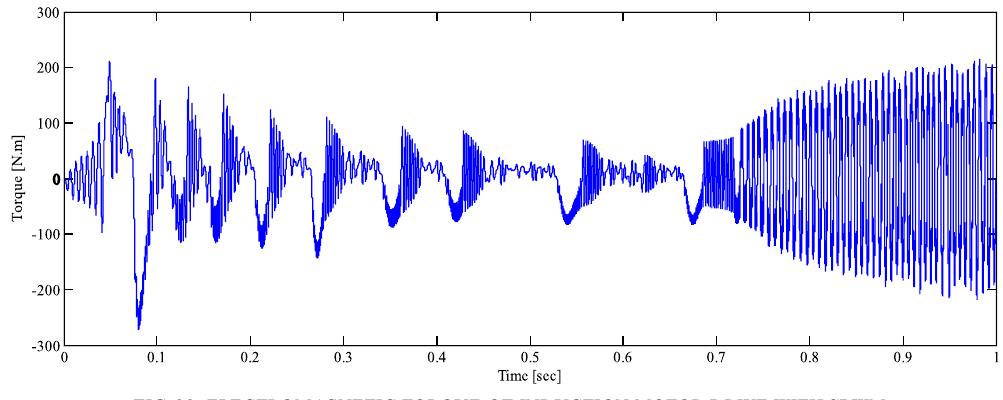
FIG. 20. ELECTROMAGNETIC TORQUE OF INDUCTION MOTOR DRIVE WITH SPWM